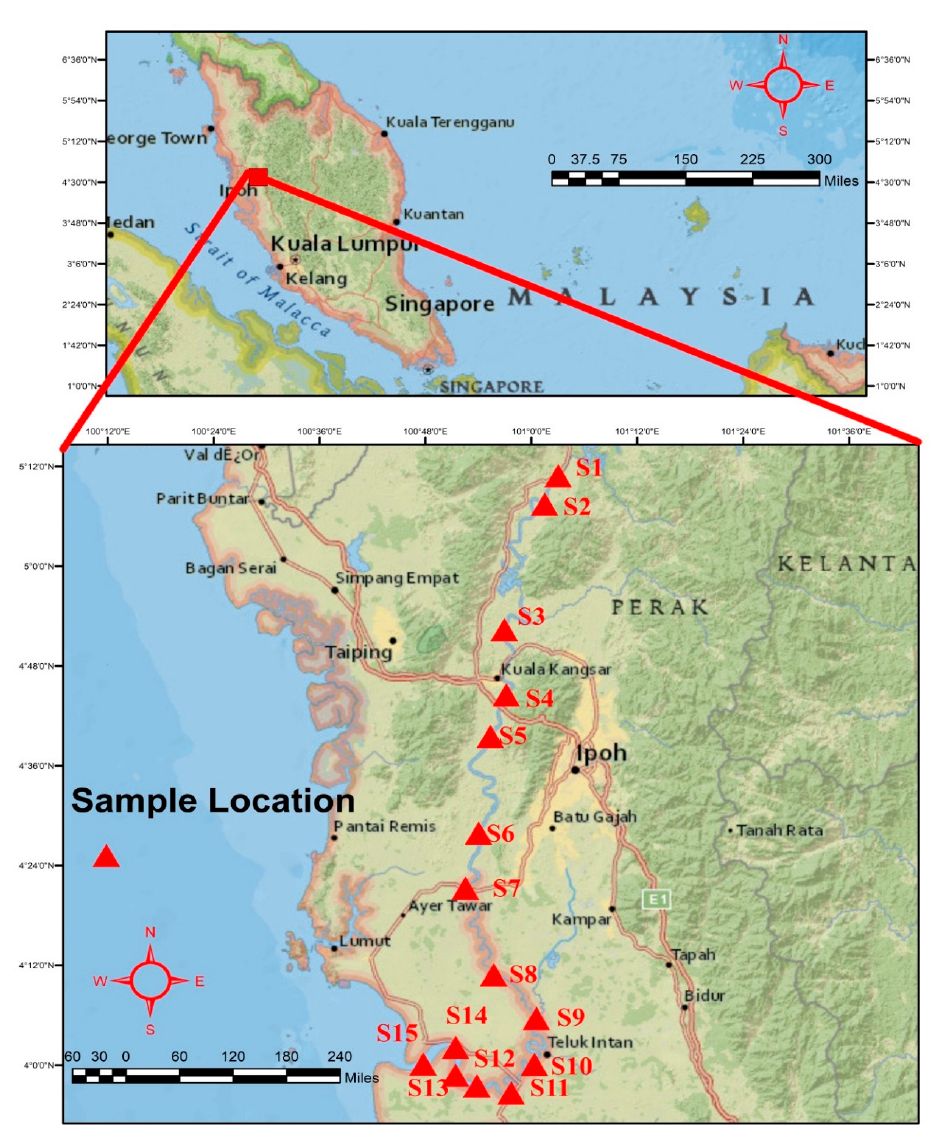
Figure 1. Geographic location of the study area along with the sampling sites in Perak River,